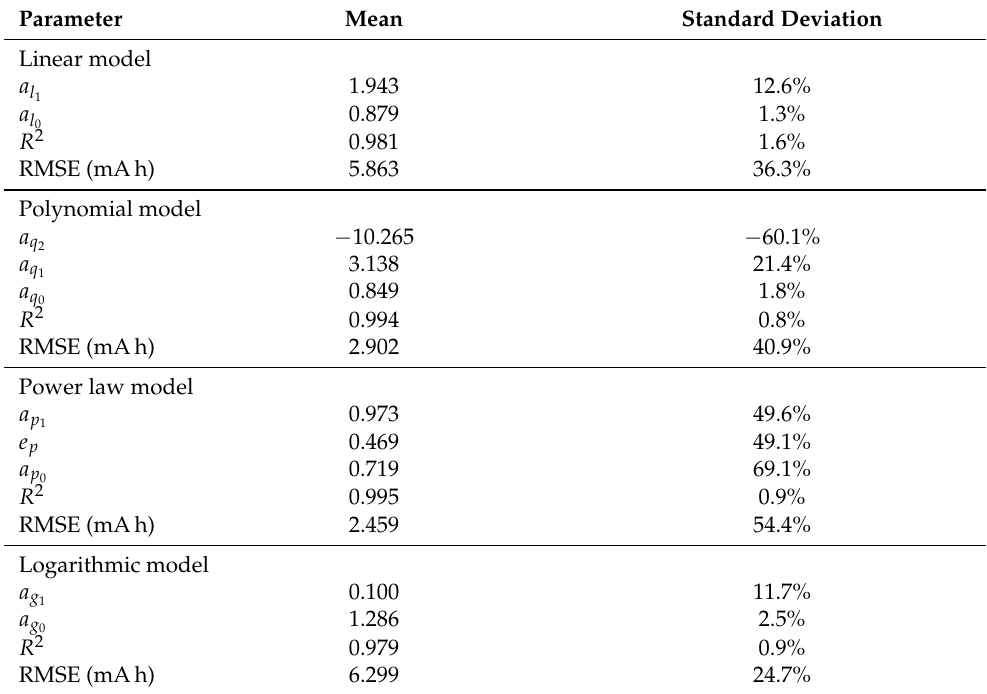
Table 2. Average values and standard deviations of the parameters of the linear, polynomial, power and logarithmic models for all 89